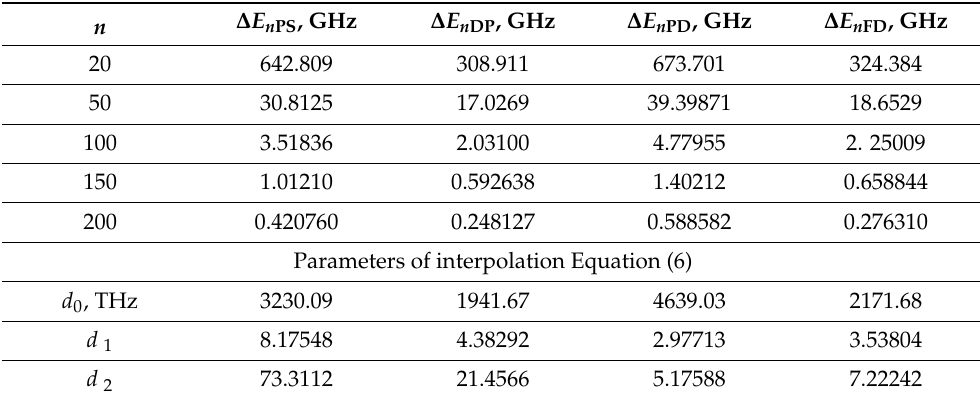
∆ E = E − E ( n + 1 ) P 3/2 ; from n DP n D 5/2 − E − 1)F n D 5/2 ; and from state ( n 7/2 to 3/2